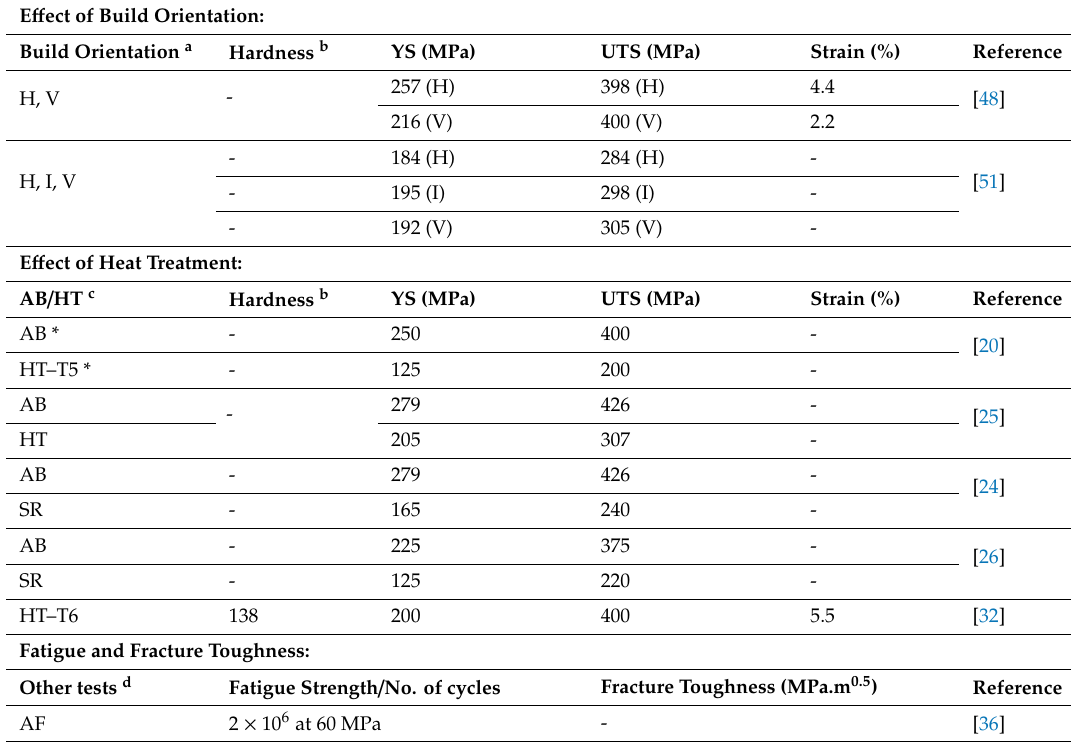
Table 6. Mechanical properties of SLM-printed A356 and